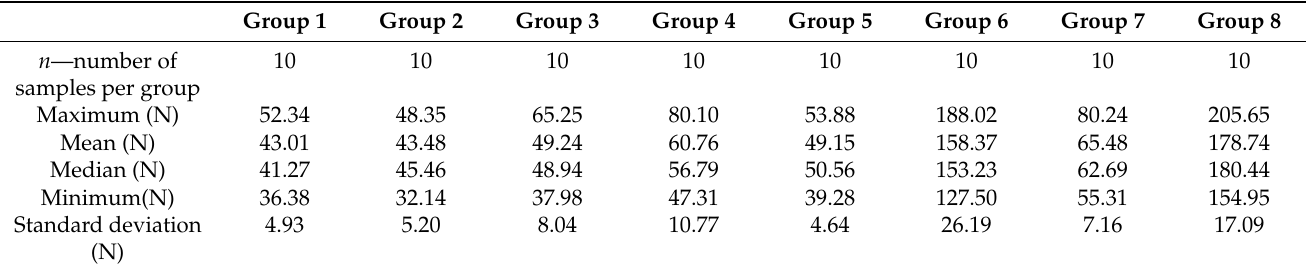
Table 2. Group-specific pull-off force values (in Newtons) compared between groups 1, 2, 3, 4, 5, 6, 7 and 8 using one-way ANOVA. The maximum, mean, median, minimum, and standard deviations are shown for the pull-off forces in groups 1–8.